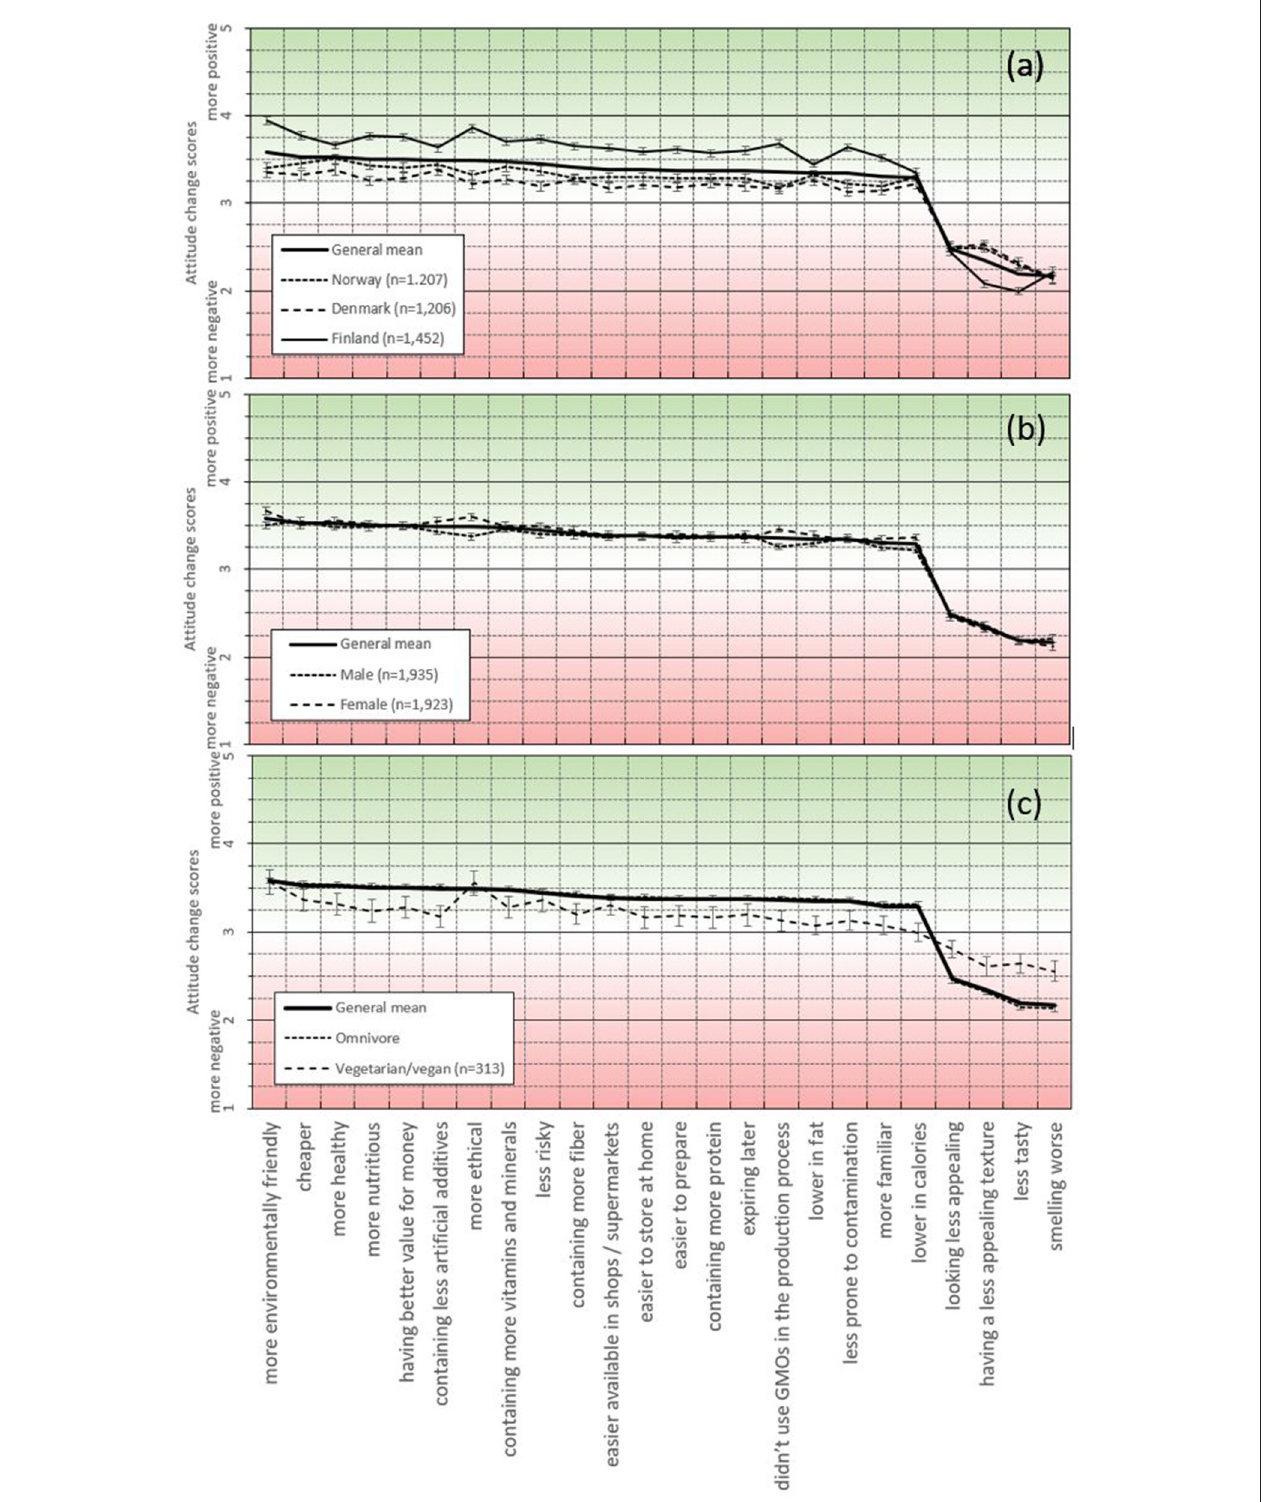
FIGURE 4 | Differences between countries (a) , gender (b) , and diet (c) . The error bars represent 95% credibility intervals estimated with Bayesian estimation.